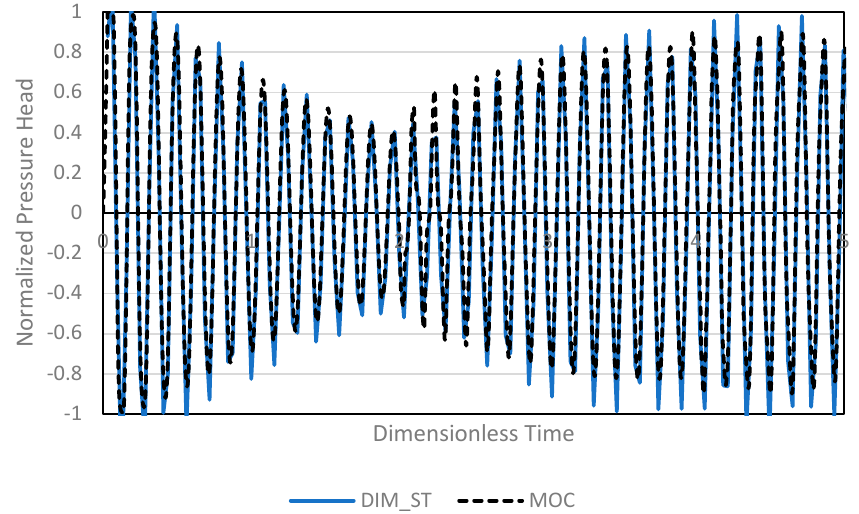
Figure 2. Predictions of normalized pressure head by DIM_ST and MOC at downstream valve. Pressure head predictions were compared between IRM with surge tank [11] and the DIM method with surge tank (DIM_ST), as presented in Figure 3. Pressure head variations and the developed